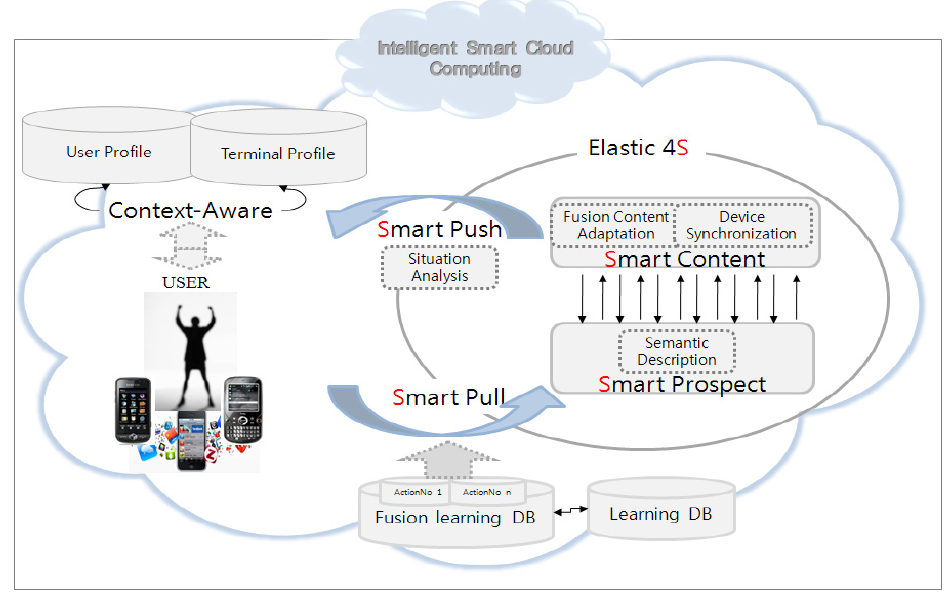
Figure 2. Smart Cloud Computing